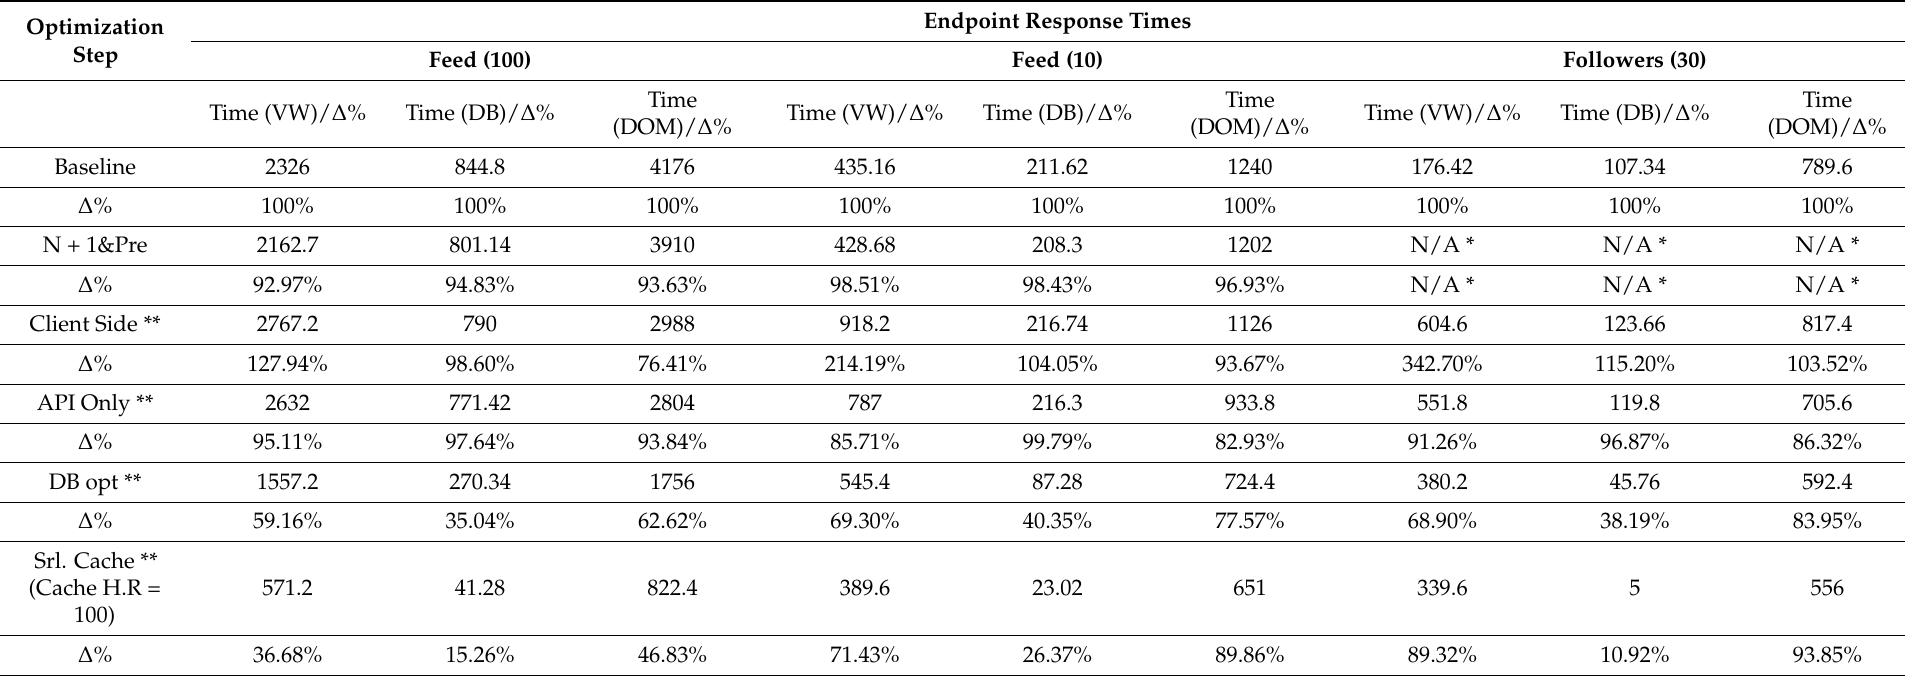
Table 4. Endpoint performance